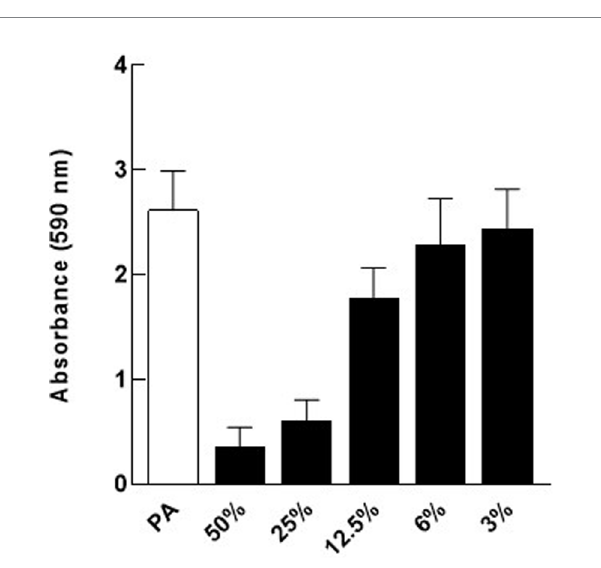
FIGURE 3 Dose response for Nissle cell-free supernatant (CFS) on P. aeruginosa (PA) biofilm. Different dilutions of Nissle cell-free supernatant were tested on P. aeruginosa biofilm to determine the minimal biofilm inhibitory concentration (MBIC). 25% ( v / v ) cell-free supernatant was the lowest concentration that caused significant biofilm inhibition against P. aeruginosa . Data are mean ± SEM, n =